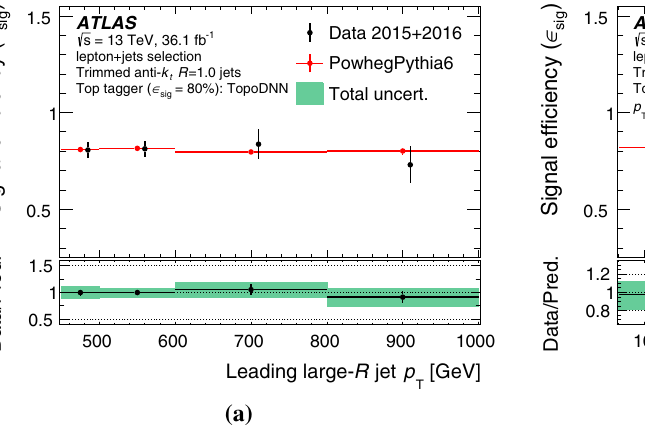
that estimated in Monte Carlo is shown with statistical uncertainties as error bars on the data points and the sum in quadrature of statistical and systematic uncertainties as a shaded band. When considering experi- mental uncertainties arising from the large- R jet, only those coming from the jet energy scale and resolution are considered